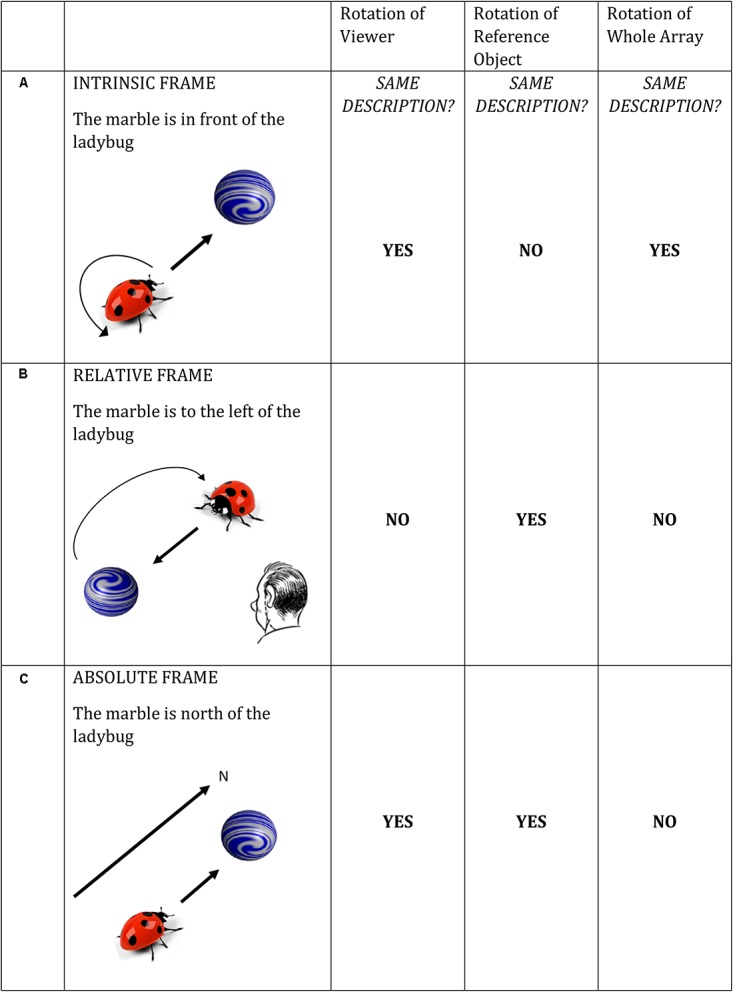
(A–C) Reference frames under conditions of rotation (adapted from Levinson, 1996).